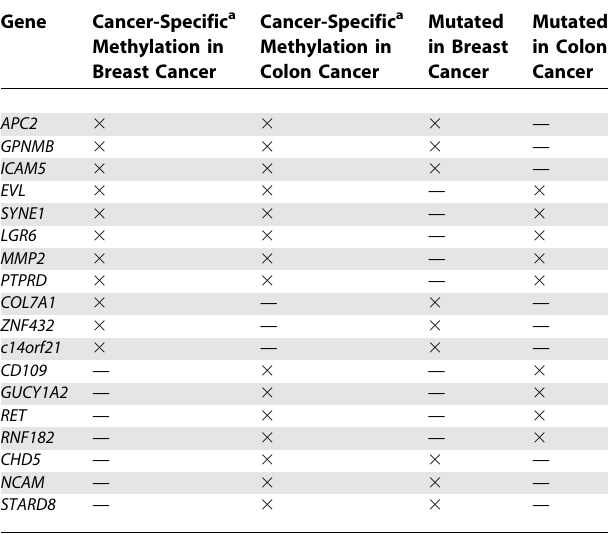
Table 2. Genetic Versus Epigenetic Events in Breast and Colon Cancer Gene